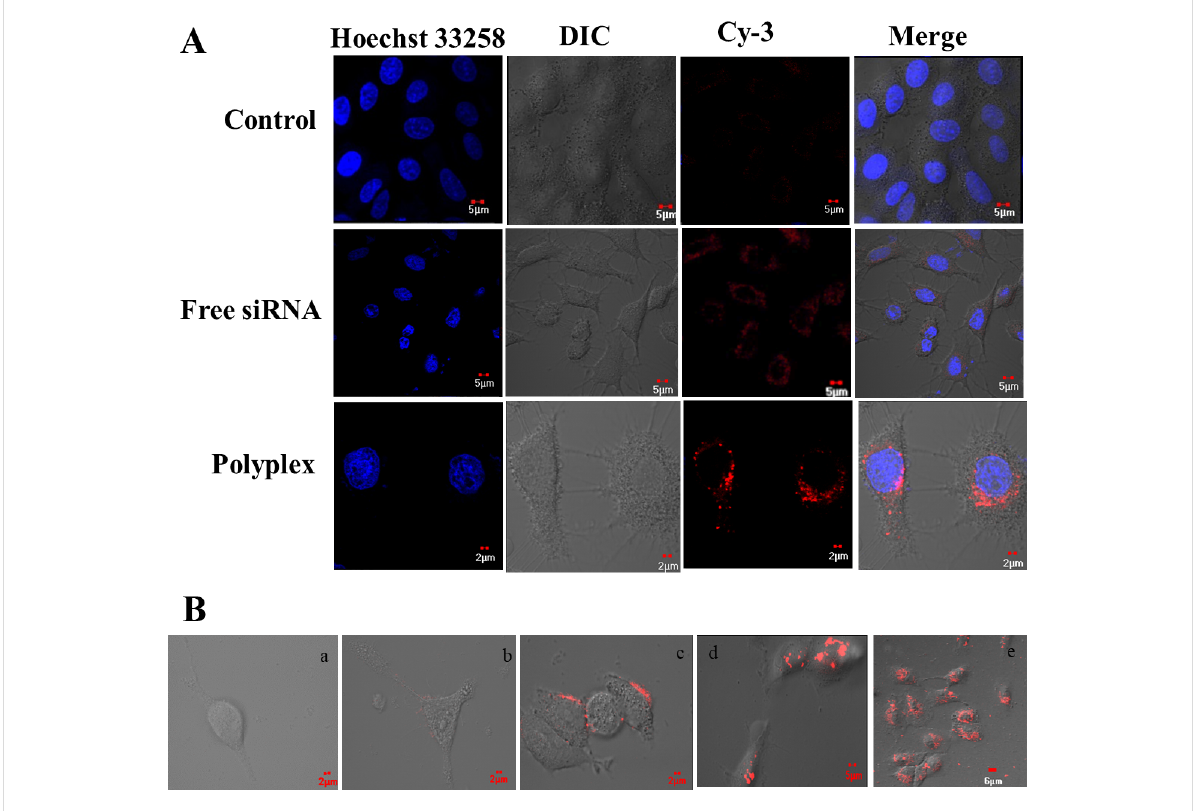
Figure 3: (A) Intracellular uptake of the polyplex monitored by using laser scanning confocal microscopy after 4 h of treatment with Cy3-labeled anti- VEGF siRNA (emission wavelength = 568 nm) at a final siRNA concentration of 100 nM and complexation at a volume ratio of 4:1. Untreated cells were used as control. Nuclei were stained with Hoechst 33258 (blue, emission wavelength = 405 nm). (B) Intracellular uptake of the polyplex after dif- ferent periods of time, a: control, b: after 30 min, c: after 1 h, d: after 4 h, e: after 16